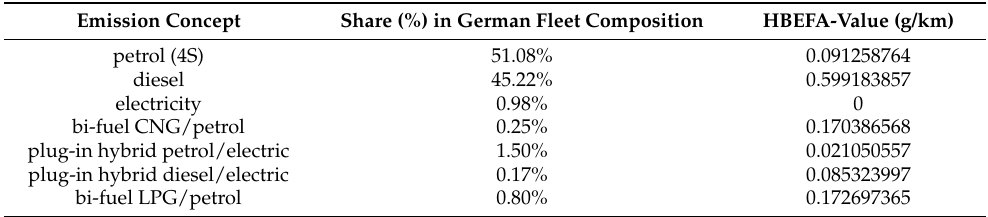
Table 1. Passenger car emission concepts and HBEFA emission factors.